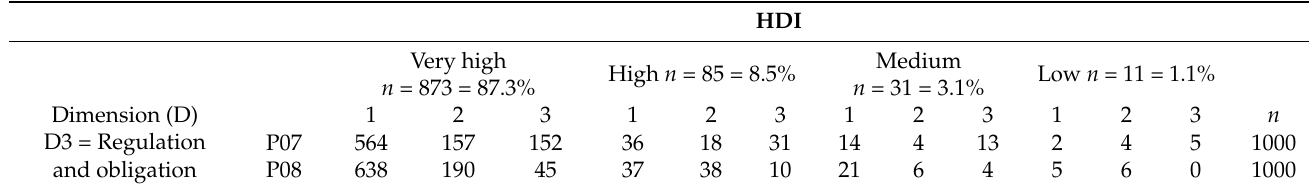
Table 9. Human Development Index (HDI) count for dimension D3.